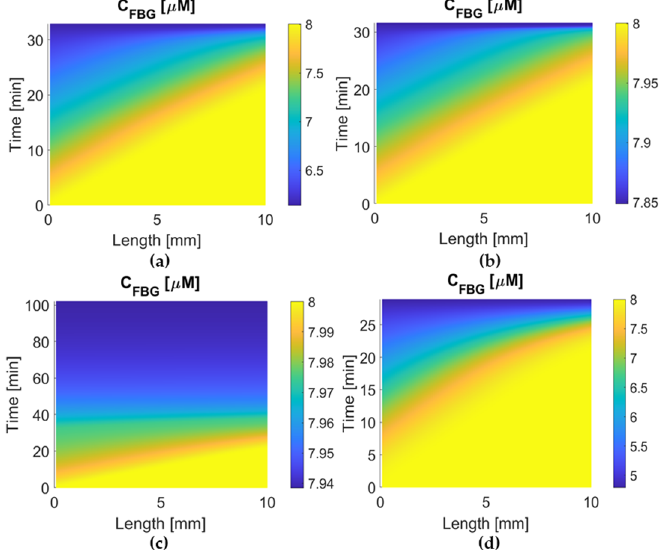
Figure 6. Temporal and spatial concentration profiles of free-phase fibrinogen for ( a ) alteplase, ( b ) tenecteplase, ( c ) reteplase, and ( d ) urokinase in the clot. Free-phase FBG concentration in the clot (lower concentration represents higher ICH risk): urokinase < alteplase < tenecteplase < reteplase.